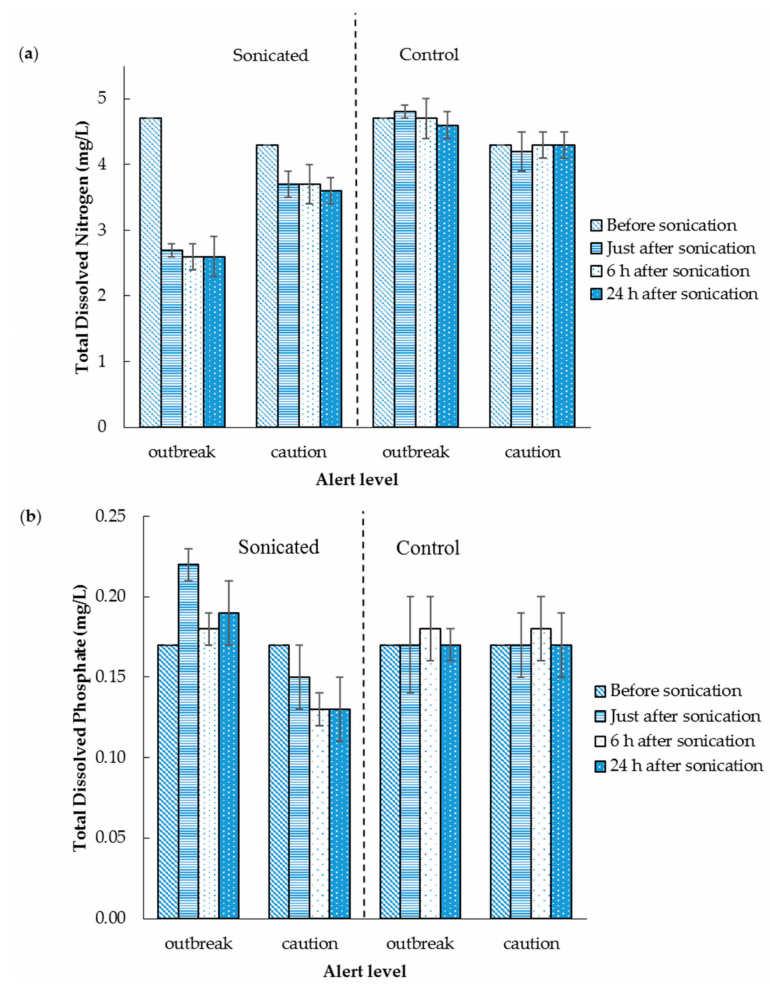
Figure 5. Immediate and long-term effect of 15 min sonication on the ( a ) total dissolved nitrogen (TDN), and ( b ) total dissolved phosphate (TDP) values of the outbreak and caution level